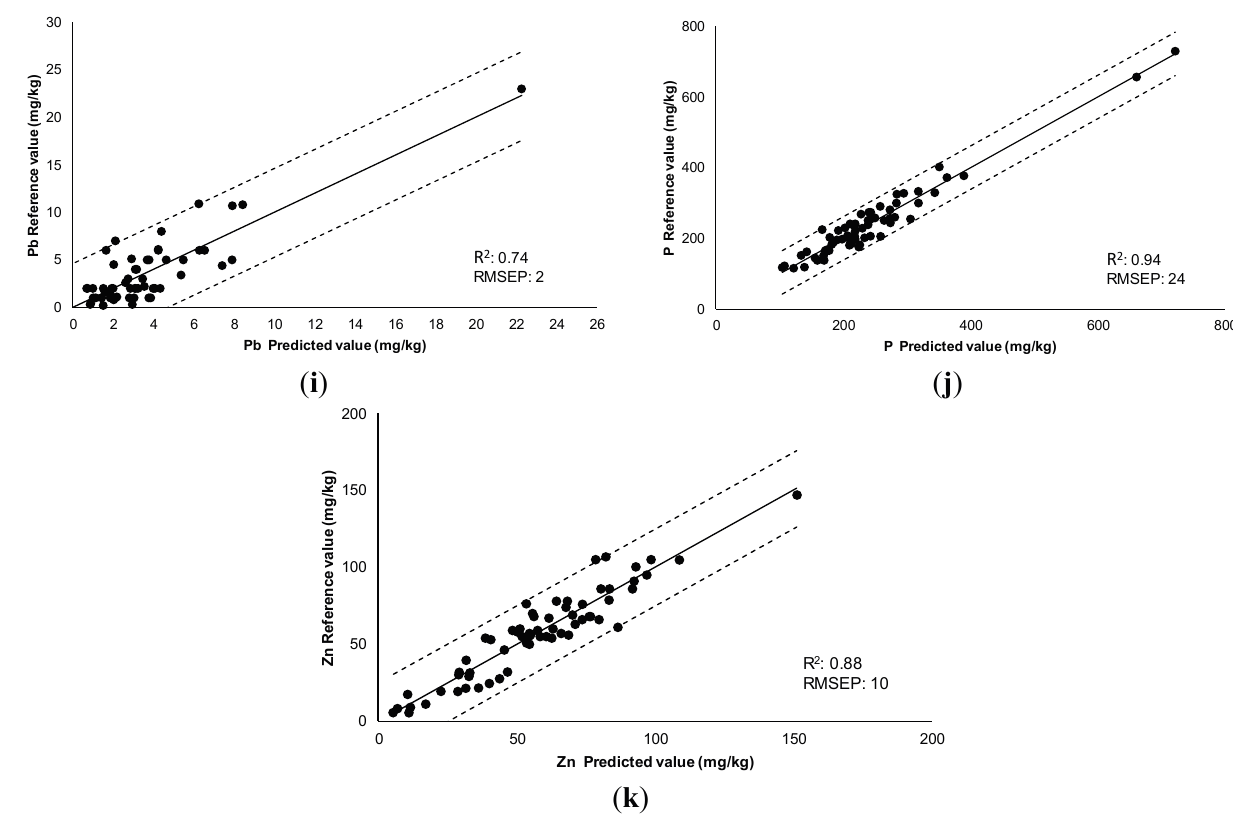
Figure 2. Comparison of reference values (mg/kg) with values predicted by the calibration equations obtained by NIR. R 2 , determination coefficient; RMSEP, root mean square error of prediction. ( a ) Al; ( b ) Ca; ( c ) Cr; ( d ) Cu; ( e ) Fe; ( f ) K; ( g ) Mg; ( h ) Ni; ( i ) Pb; ( j ) P; ( k ) Zn.